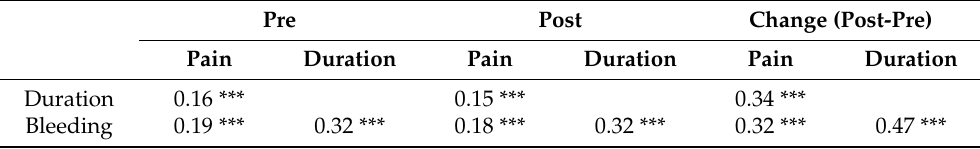
Table 4. Spearman’s Rho correlation before menstrual pain, duration and bleeding and after the